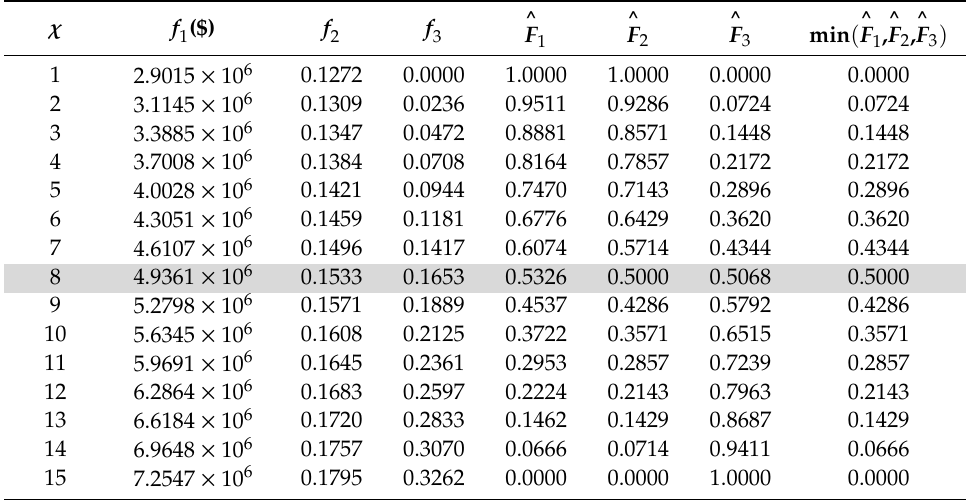
Table 7. Obtained Pareto optimal solutions for the deterministic multi-objective RPP considering the loadability factor.